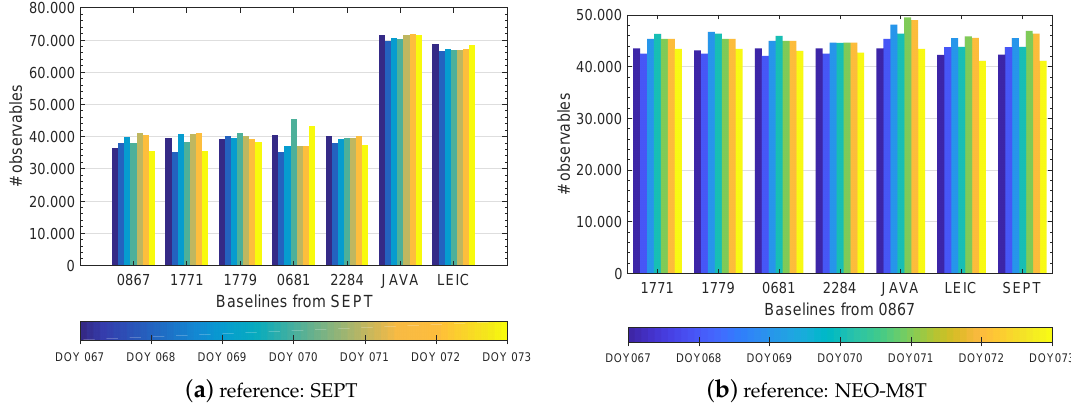
Figure 12. The maximum number of available observations for DD calculation in Bernese GNSS software depends on the number of available tracking channels thus resulting in dependencies in the combination of receivers, ( a ) SEPT as reference, ( b ) NEO-M8T receiver (0867) as